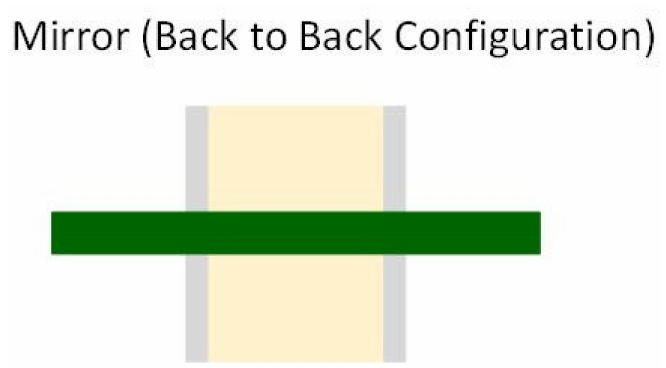
Figure 12. Mirror or Back-to-Back layout